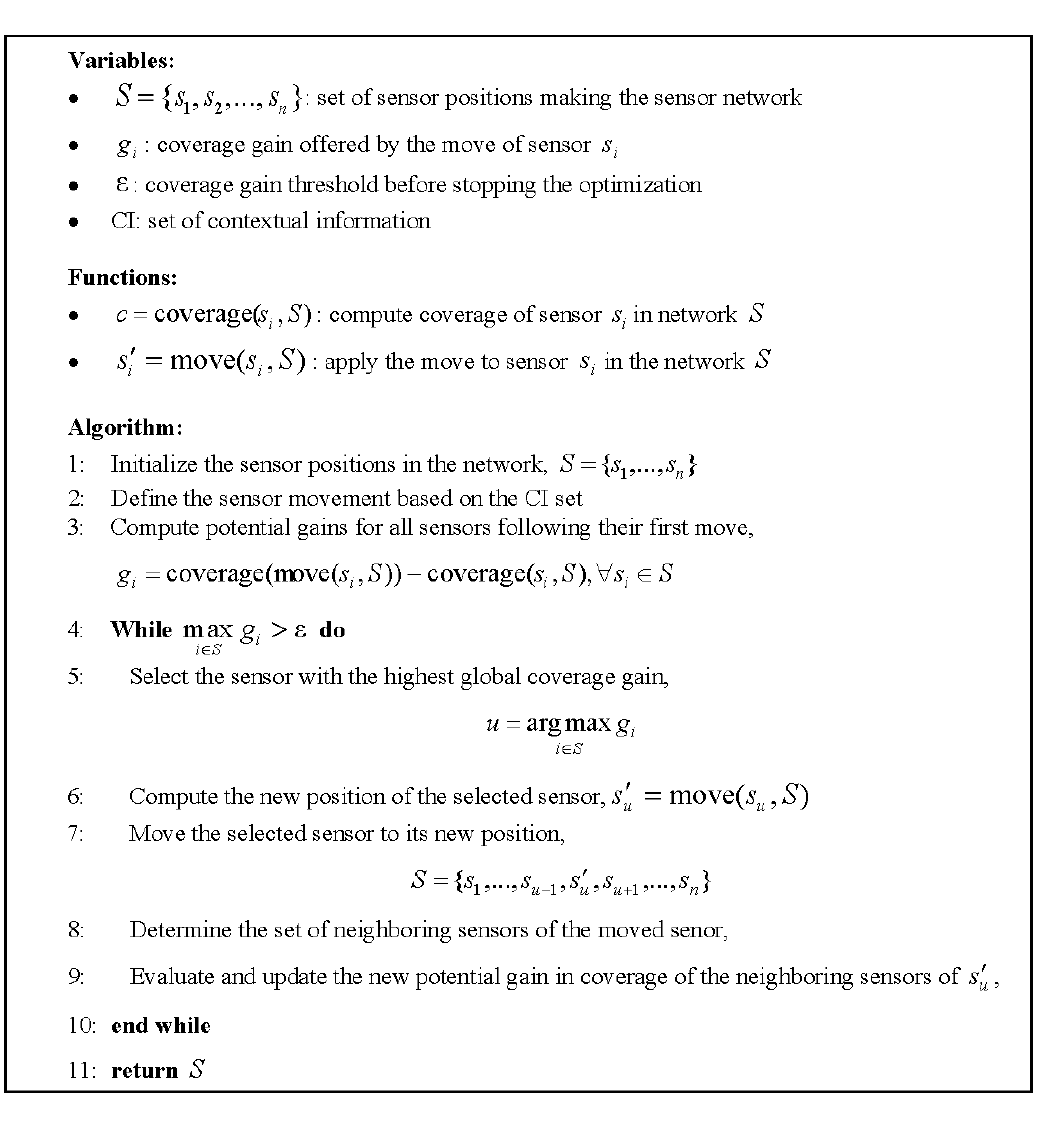
Figure 4. The pseudo-code of the proposed local context-aware optimization